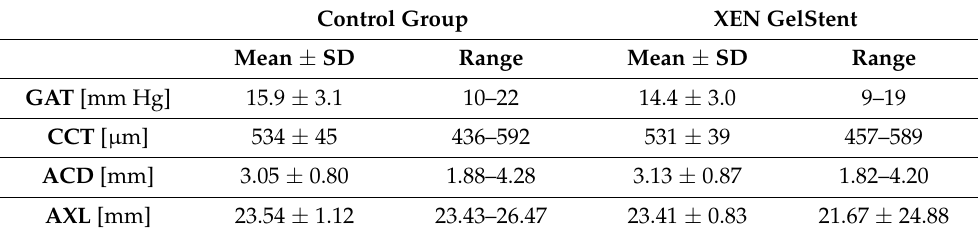
Table 1. Demographic